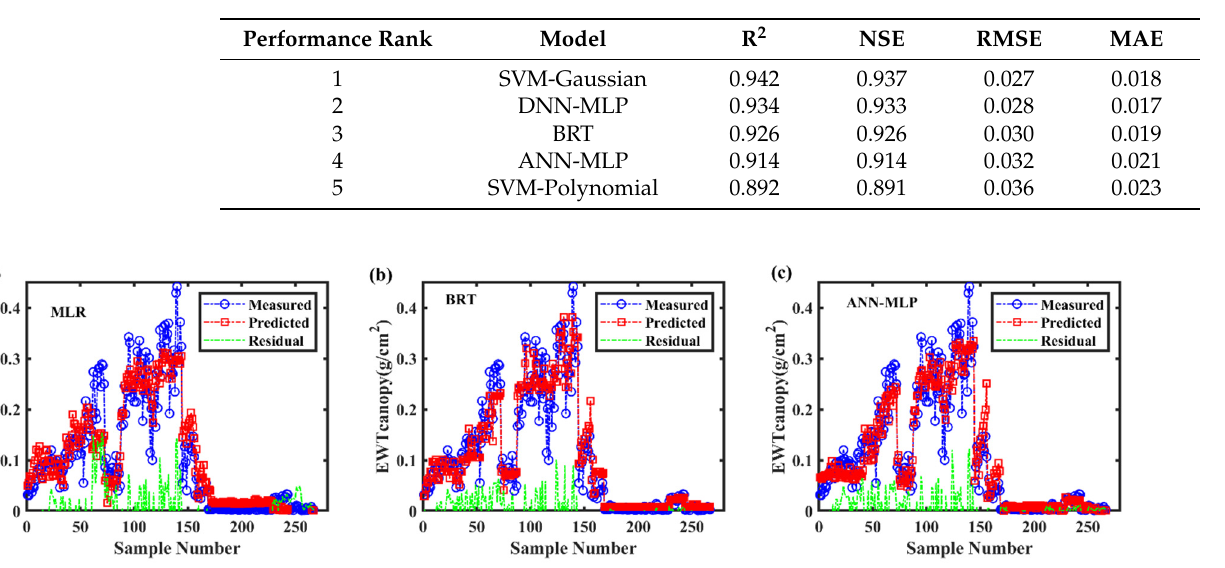
Table 8. Comparative performance statistics of the machine learning (ML) models employed in the study.